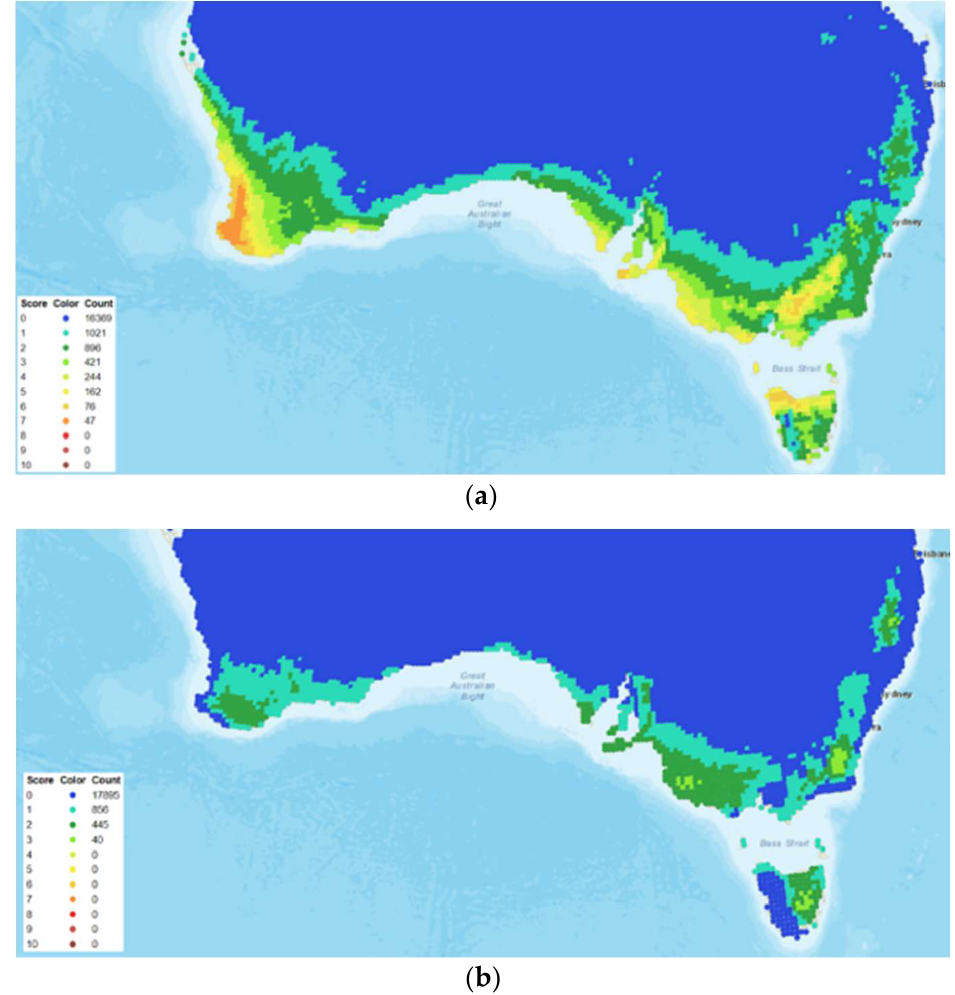
Figure 6. ( a ). Climate match for germplasm origin sites in Chile with Australia. ( b ). Climate match for germplasm origin sites in Bolivia with Australia.